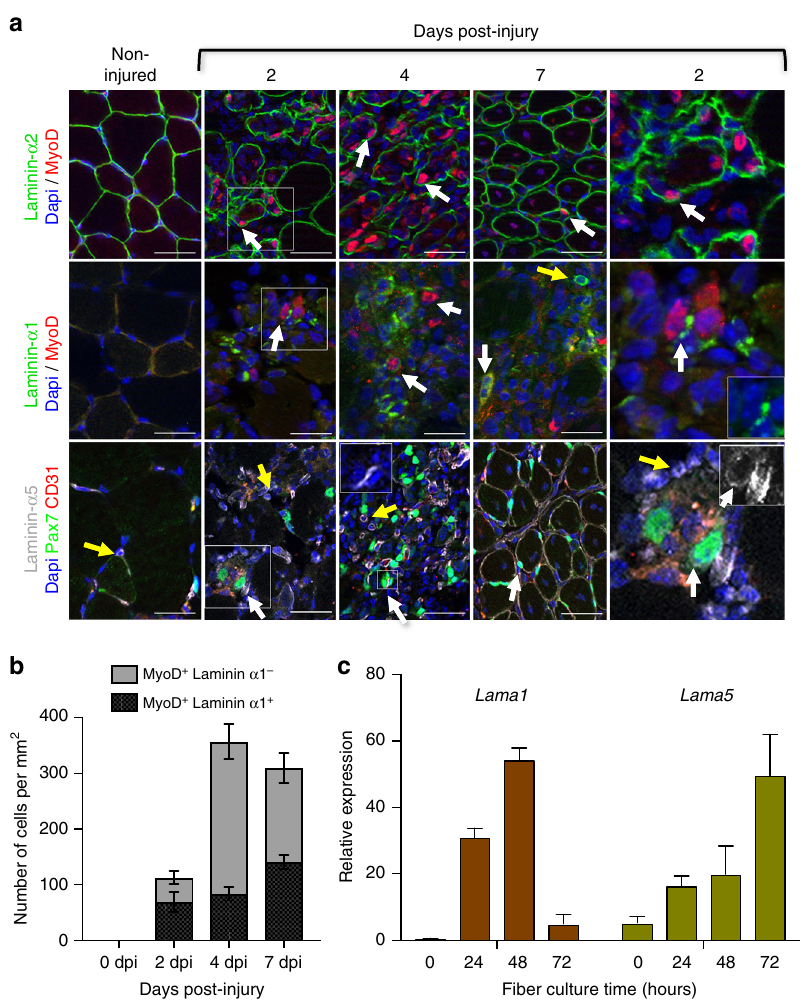
Fig. 2 Spatio-temporal distribution of laminin- α 1 and laminin- α 5 in regenerating muscles. a Immuno fl uorescence analysis of laminin- α 2 (green, top panels), laminin- α 1 (green, middle panels), and laminin- α 5 (gray, bottom panels) in regenerating TA muscle following cardiotoxin-mediated injury. Panels on the right are high magni fi cation images of the 2 dpi images (indicated by a white rectangle, with small inserts showing the same image with the laminin channel only). The insert shown at 4 dpi in the laminin- α 5 panels illustrates increased laminin α 5 (white) deposition at the surface of satellite cells. White arrows indicate satellite cells. Yellow arrows indicate MyoD − or Pax7 − (GFP − ) cells positive for laminin- α 1 or α 5. Scale bar, 50 μ m. b Quanti fi cation of the number of laminin- α 1 + myogenic cells in regenerating muscles. c qPCR analysis of Lama1 and Lama5 gene expression in myo fi bers cultured for 0 – 72 h. n = 6 experiments. Graphs show mean +